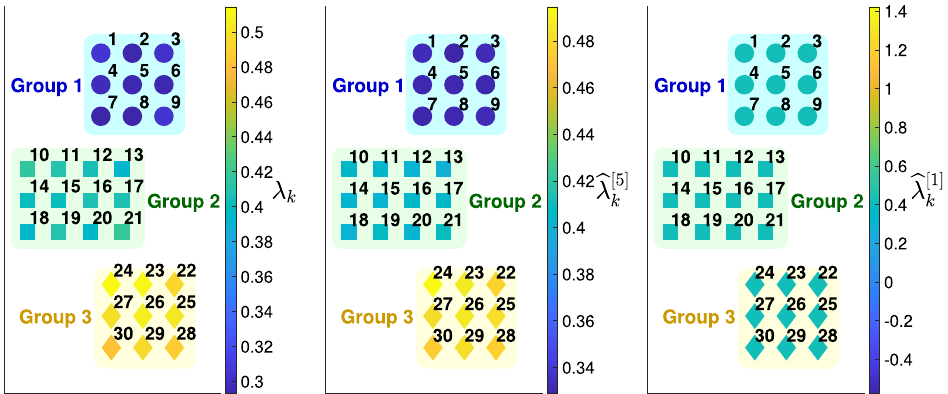
Figure 4. Maps of the thirty provinces divided into three groups, colored by transmission parameters or their estimates. In all the three panels, the circles on top of the panels denote the nine provinces in Group 1 (indexed by 1–9), the squares in the middle of the panels denote twelve provinces in Group 2 (indexed by 10–21), and the diamonds at the bottom of the panels denote nine provinces in Group 3 (indexed by 22–30). The provinces are colored by the ground truth { (cid:31) k } 30 k = 1 in the left panel, by the averaged estimates { (cid:31) (cid:31) the middle panel, and by the averaged estimates { (cid:31) (cid:31) and [ 1 ] denote the models used to obtain the estimates of (cid:31) k . In the experiments, the traveling volumes between provinces are taken to be